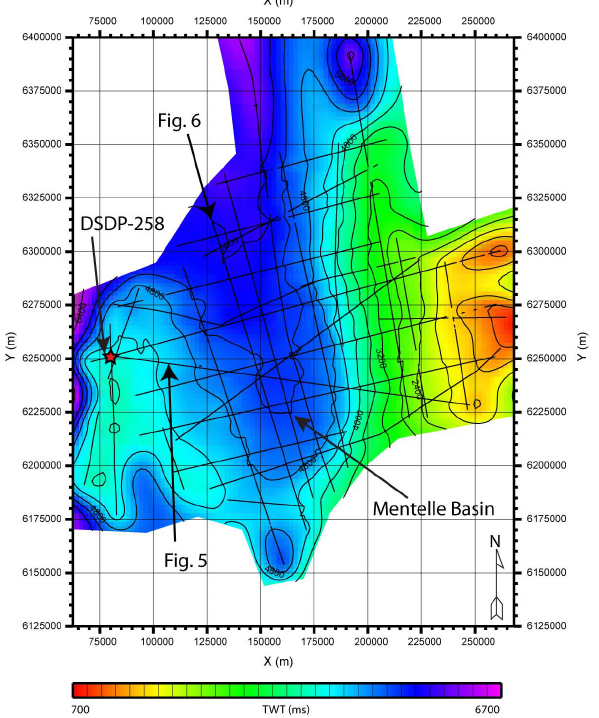
Fig. 10. TWT map of the intra black clay unconformity (within the Base Albian megasequence) upon which younger Cretaceous megasequences onlap.